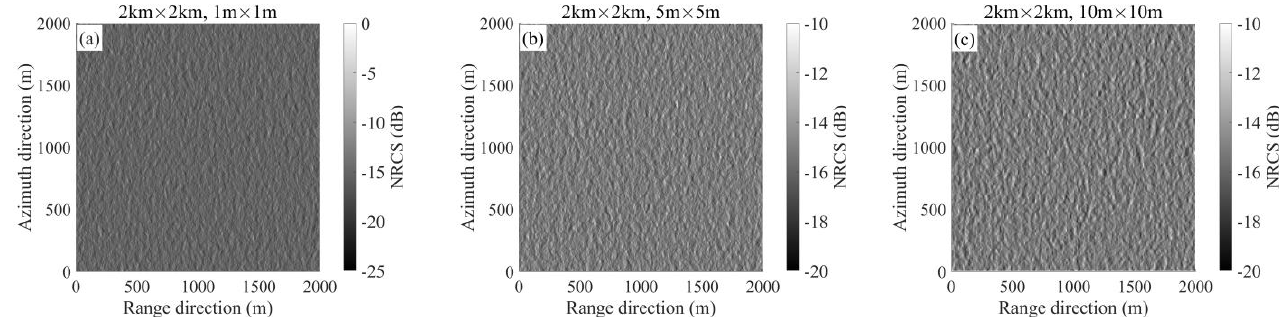
Figure 27. Comparisons of the scattering images based on different facet sizes in the upwind direc- tion at the incidence angle of 40° and wind speed of 10 m/s under VV polarization. The surface size is 2 km × 2 km. ( a ) The facet size is 1 m × 1 m; ( b ) the facet size is 5 m × 5 m; ( c ) the facet size is 10 m × 10 m.